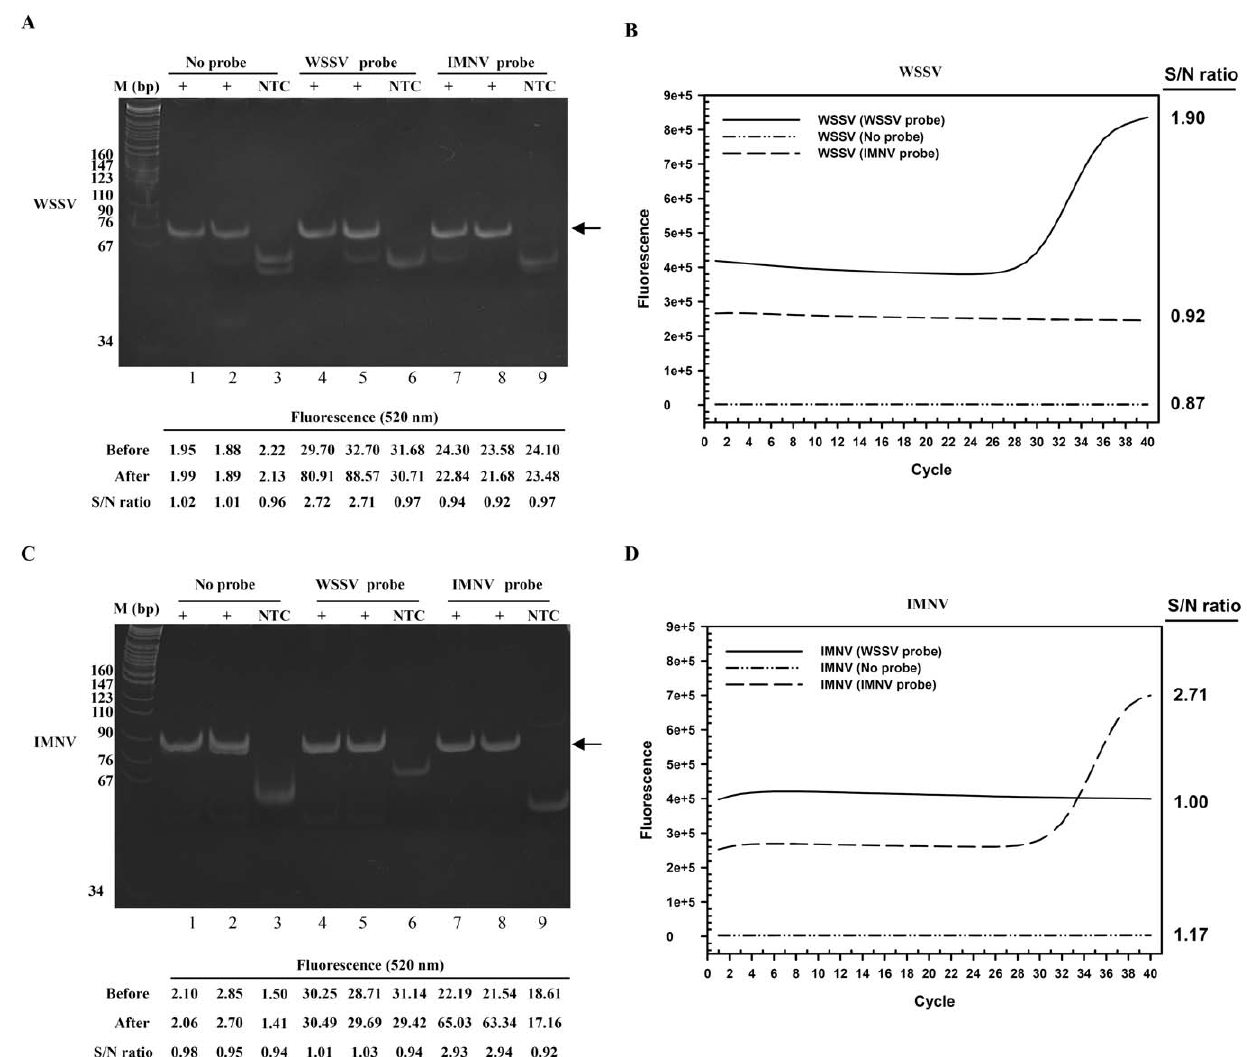
Figure 2. Generation and detection of TaqMan probe hydrolysis in iiPCR. Target pWSSV1 and pIMNV plasmids (10 3 copies) were subjected to WSSV (A) and IMNV (C) iiPCR, respectively, for 30 min in the presence of WSSVprobe, IMNVprobe, or no probe. Fluorescent signals (520 nm) of individual reactions were collected before and after iiPCR by the modified iiPCR and shown below the gel image. After the reactions were completed, amplicons were also analyzed on a 12% polyacrylamide gel in 1X TAE buffer. WSSV (B) and IMNV (D) real time PCR assays containing the same components as in iiPCR were carried out as described in Materials and Methods. The result shown here is a representative of at least three experiments with similar results. Arrows, iiPCR amplicons; M, DNA size markers; NTC, no template control (ddH 2 O); ‘‘before’’, fluorescent signals detected before reaction; ‘‘after’’, fluorescent signals detected after reaction; S/N ratio, signal intensity after /signal intensity before for iiPCR; signal intensity cycle 40 /signal intensity cycle 1 for real time PCR.